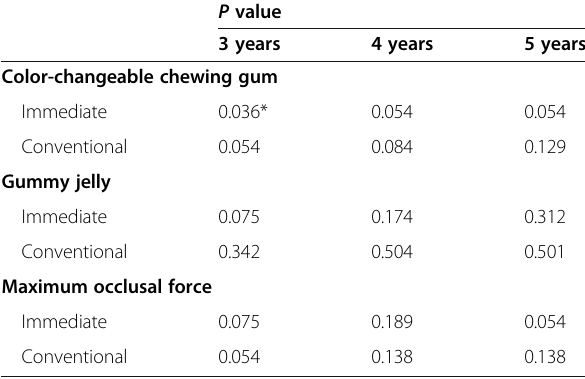
Table 3 Comparison of P values in masticatory performance and maximum occlusal force within each group